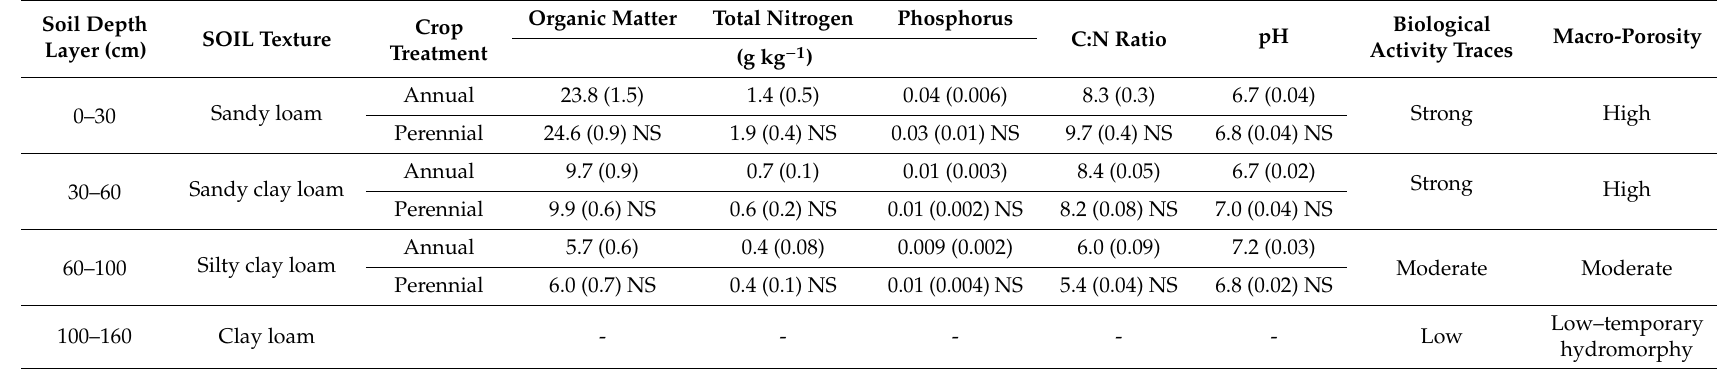
Table 1. Baseline soil profile characteristics (numbers in brackets indicate standard errors). Both perennial and annual crops areas are characterized through 6 di ff erent soil samples, and compared by means comparison (Student tests). p -value are indicated as follow: NS = no significant ( p -value > 0.05), S = significant ( p -value <